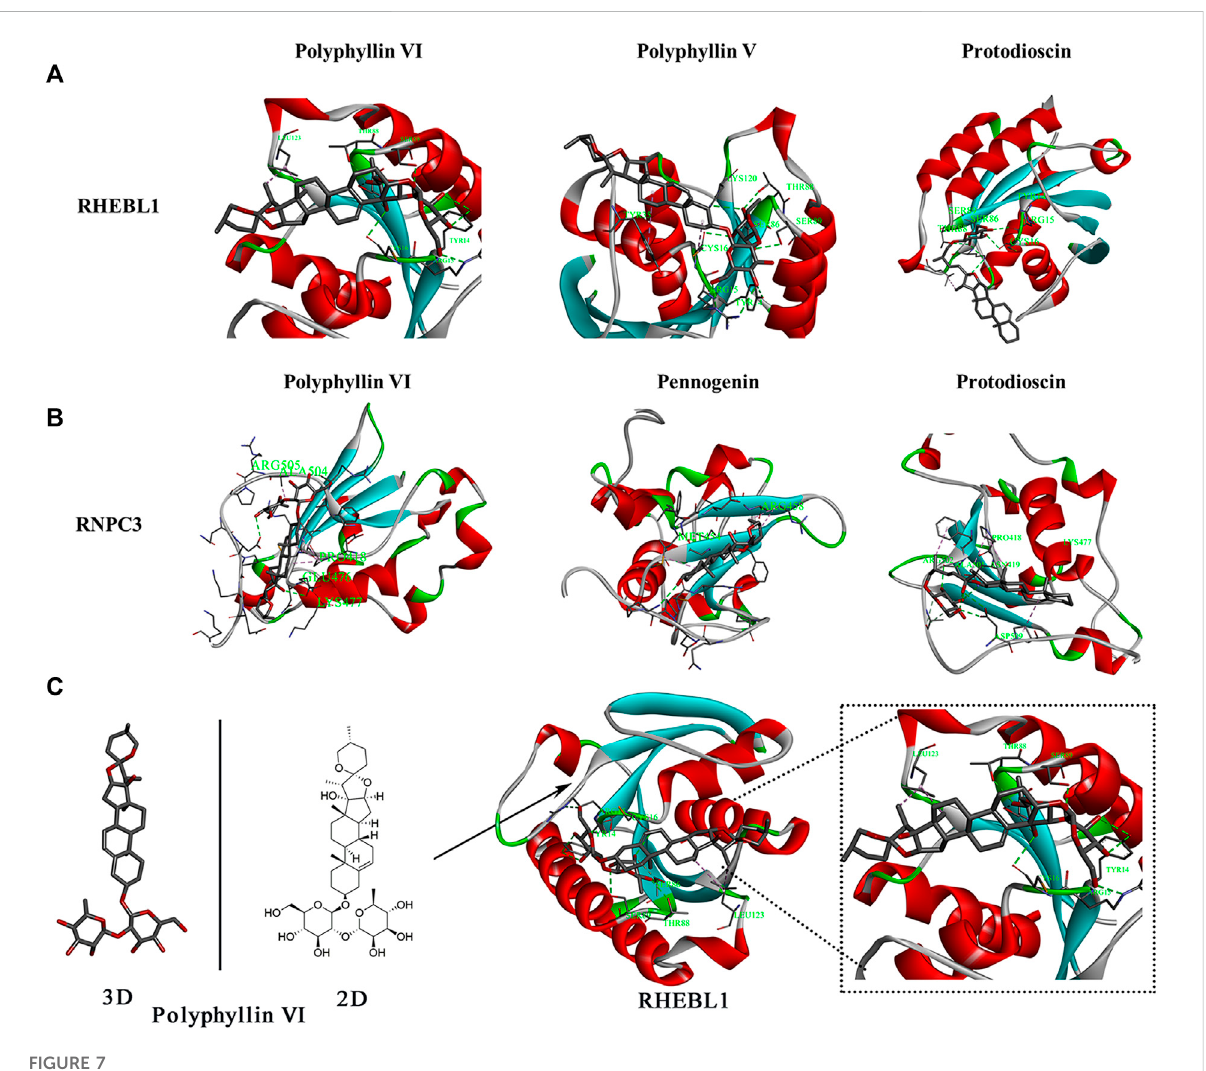
introduction of the validation set GSE44077 to validate the fi ve genes screened (Figure 4D) revealed that the expression levels of RNPC3 ( p = 0.00036) in lung cancer tissues of non- small cell lung cancer were signi fi cantly higher than those of matched normal controls, and the expression levels of RHEBL1 ( p = 6e-0.9) were signi fi cantly lower than those of matched controls; while DOCK6 ( p = 0.81), PIWIL2 (0.24) and GPC (0.055)were not signi fi cantly different between the disease and normal control groups. P < 0.05 was considered a signi fi cant difference. screened by support vector machine recursive feature The above screening revealed that the expression levels of elimination (SVM-RFE) (Figure 4B; Supplementary Figure RNPC3 and RHEBL1 differed signi fi cantly in treatment and S3). The intersection of the two was taken to screen fi ve control group. To further verify the accuracy of these non-small cell lung cancer signature genes from the differential genes as diagnostic genes for non-small cell lung training sets GSE151103 and GSE33532: DOCK6, GPC2, cancer, ROC curve analysis of the above these genes (Figure 4C). The